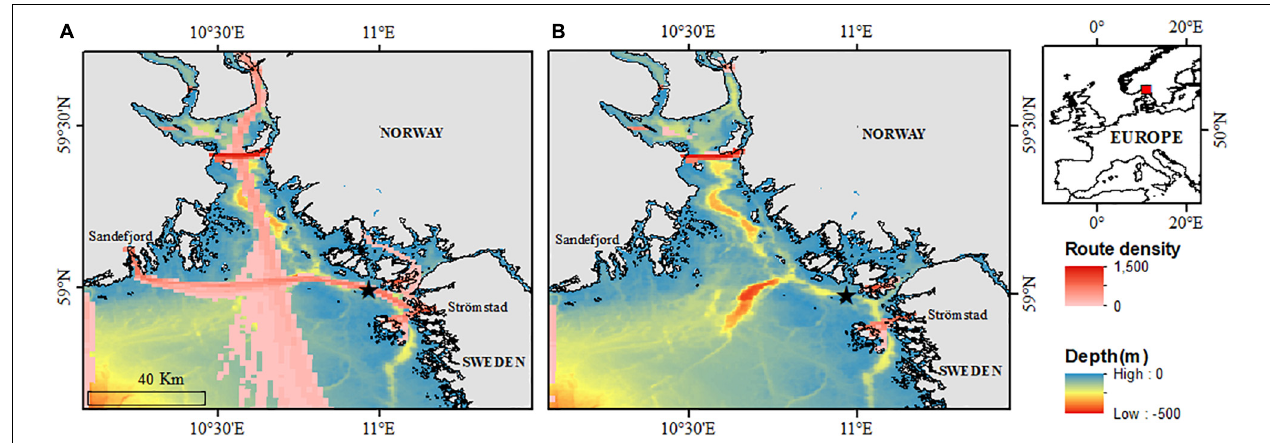
FIGURE 2 | Map indicating the location of the Tisler cold-water coral reef (black star and red square) and the passenger routes density (Source: EMODnet Human Activities: EMSA Route Density Map) in (A) February 2020 (before COVID-19 border closure) and (B) April 2020 (after COVID-19 border closure).